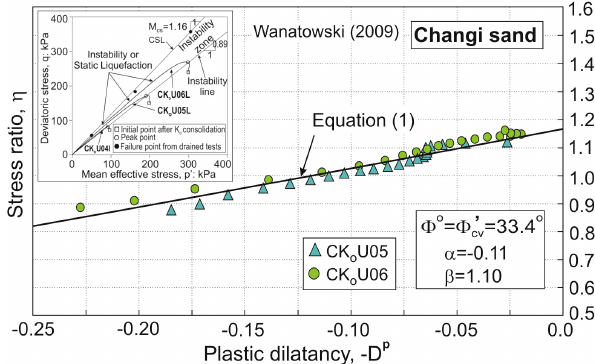
Fig. 11. Stress ratio-plastic dilatancy relationship for the collapse behaviour of Changi